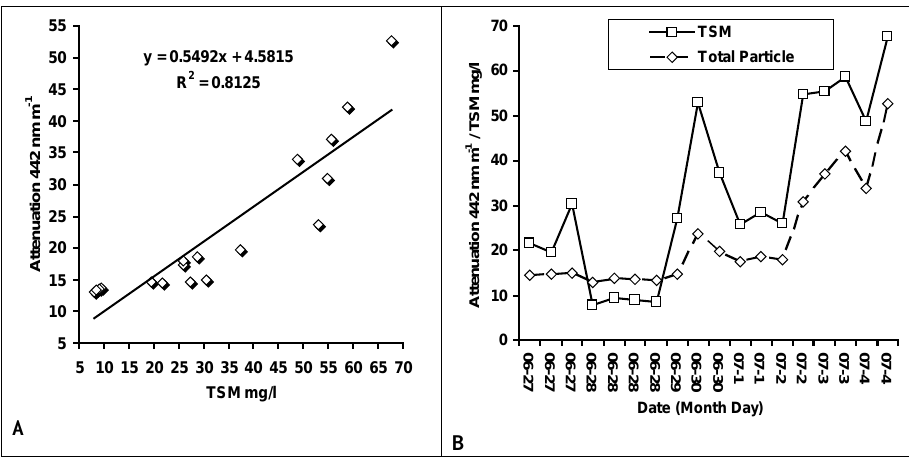
Fig. 8. Co-variation (A) and temporal variations (B) of TSM and the beam attenuation at 442nm.